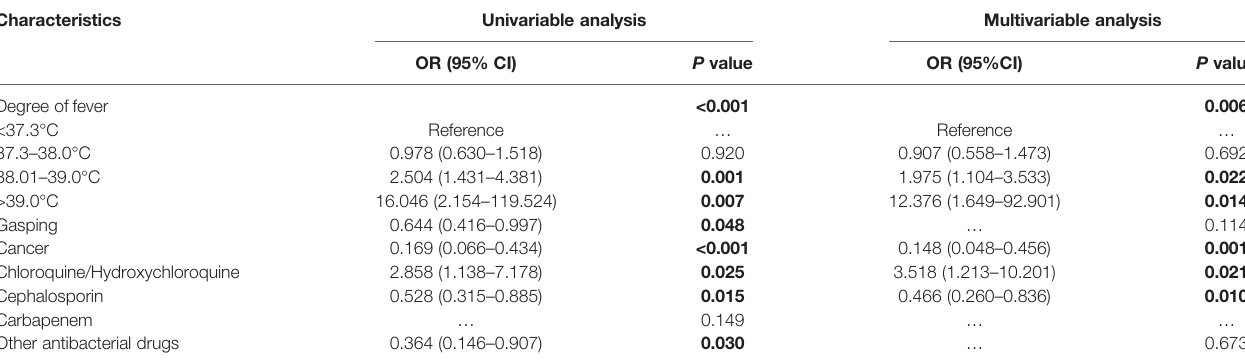
TABLE 3 | Factors associated with IgG response by univariable analysis and multivariable analysis, adjusted by disease severity.